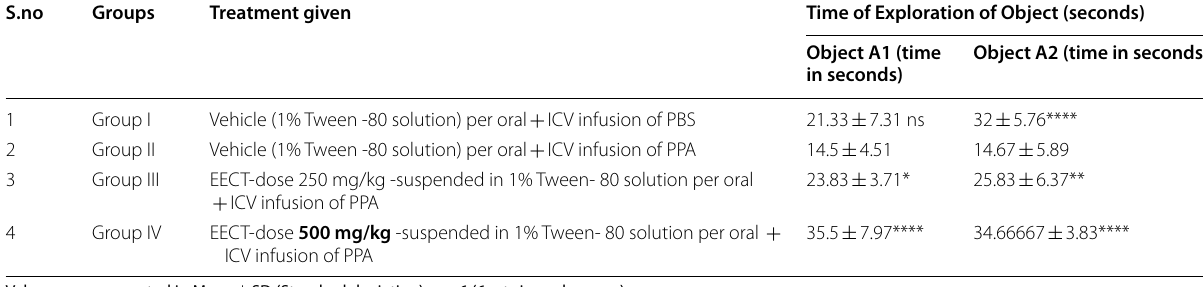
Values are represented in Mean Comparison: Group II vs Group I, Group II vs Group III, and Group II vs Group IV ns nonsignificant